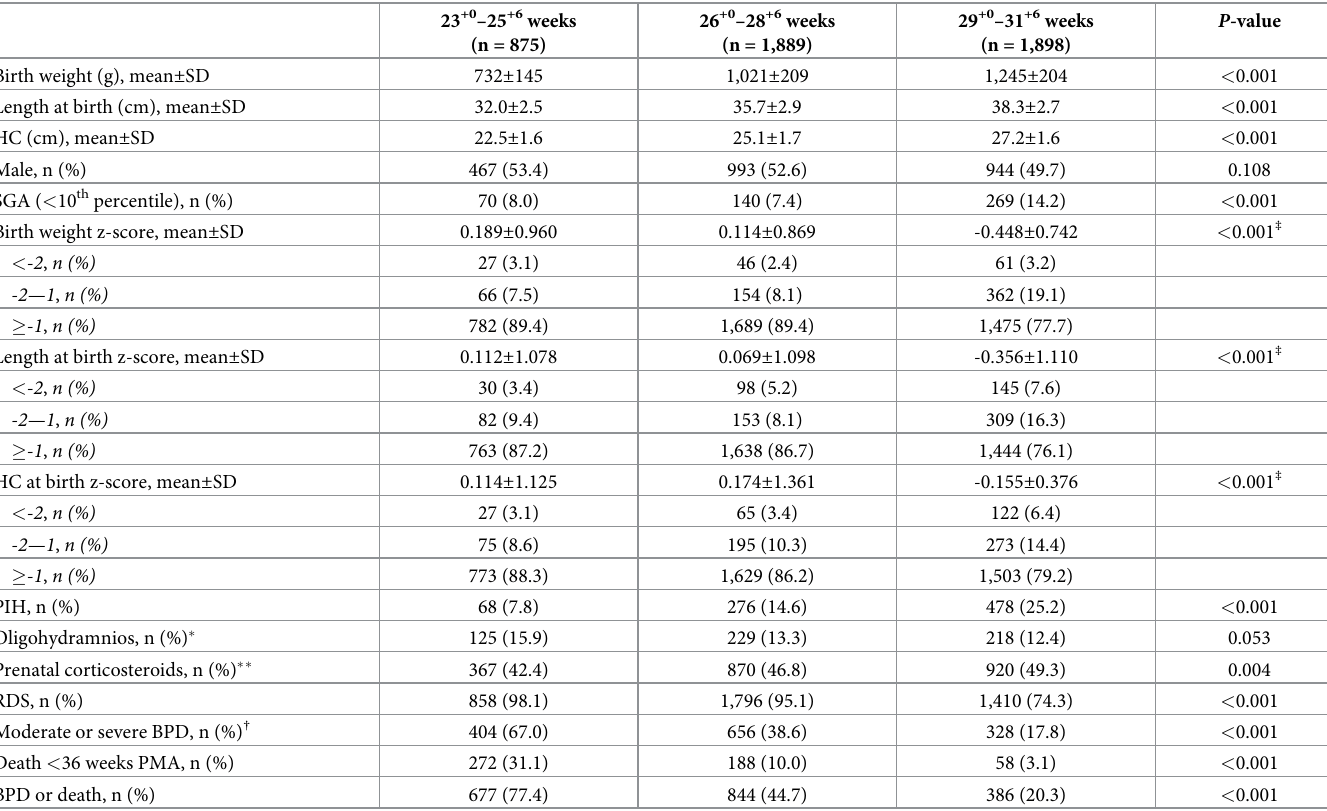
Table 1. Anthropometric measurement values at birth, and the maternal and neonatal characteristics in each gestational age